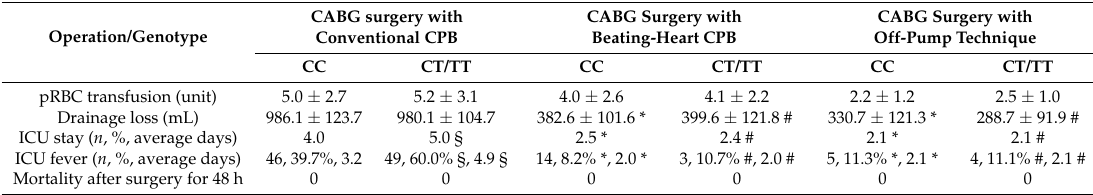
Table 5. Perioperative characteristics ( n = 347) in elective CABG patients. CABG surgery with Operation/Genotype Conventional CPB